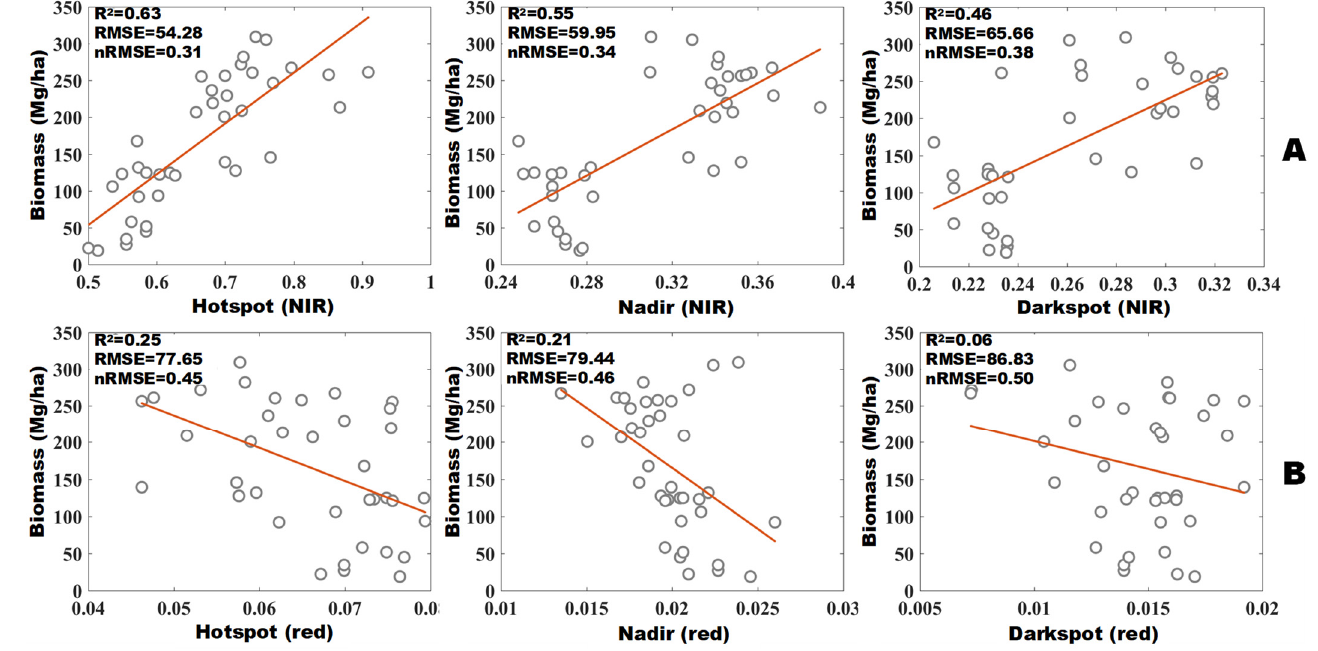
Figure 6. Linear regression results for estimating forest AGB using MODIS typical-angle reflectances based on 36 selected sets of field-based forest biomass data; all used field-based biomass data are shown in Appendix A Table A1; row ( A ) is the result of the NIR band; row ( B ) is the result of the red band.